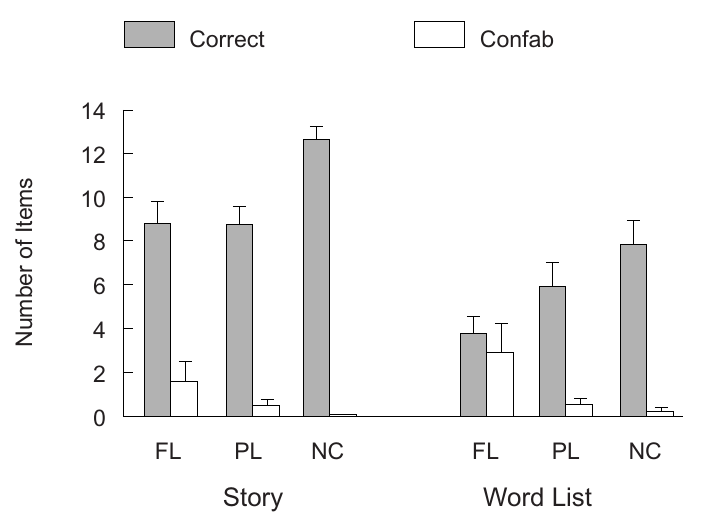
Fig. 1. Mean number of correctly reproduced items ( ± SEM) and mean number of confabulatory responses ( ± SEM) for story and word list recall. Table 3 Results for recall and recognition of five dot patterns (means